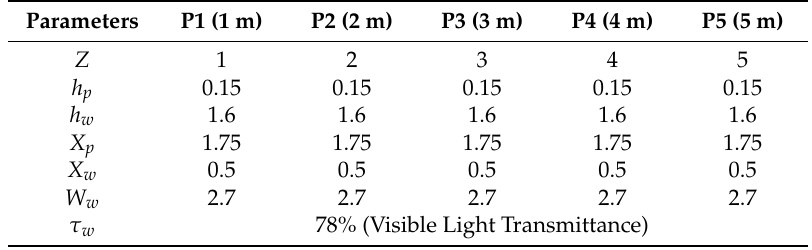
Table 4. Illuminance sensor geometry and glazing transmittance of analysis model. ( z = The horizontal distance between the window and sensor point (m), h p = Height between lower edge of the window and sensor point (m), h w = Window height (m), X p = Distance between sensor point and left wall (m), X w = Distance between the left edge of the window and left wall (m), W w = Window width (m), τ w = Visible light transmittance